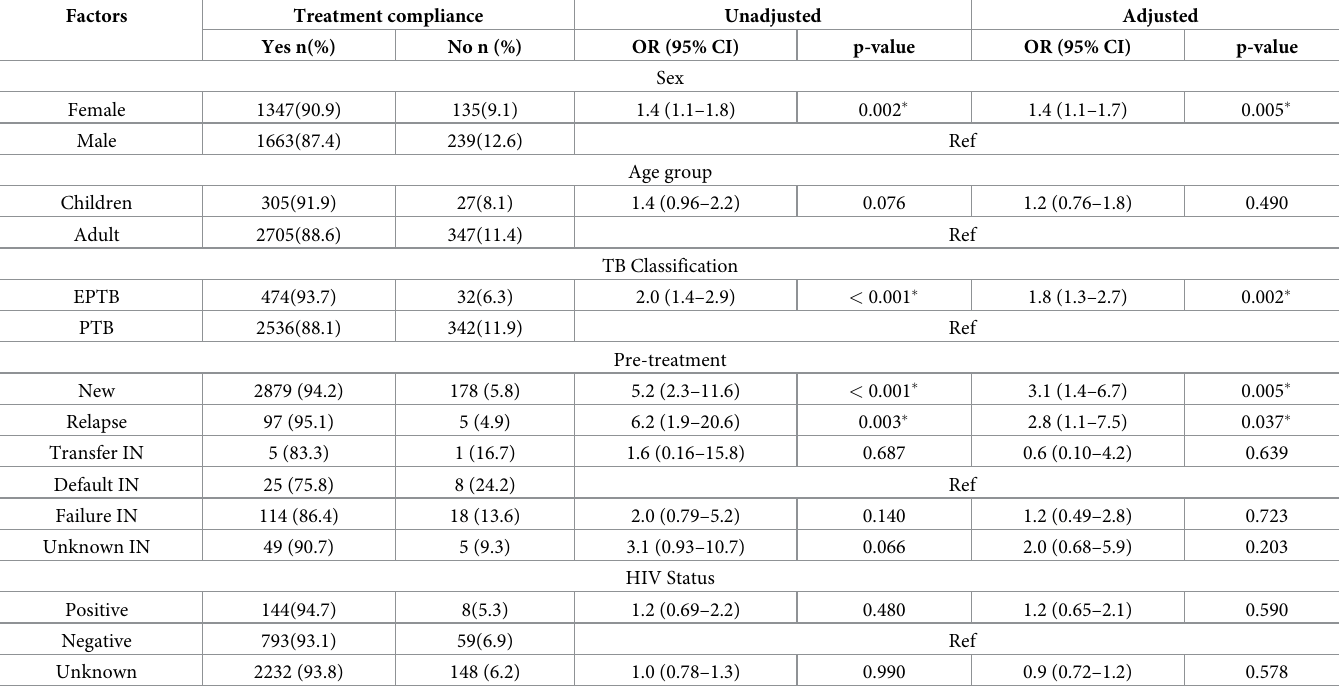
Table 3. Factors associated with treatment